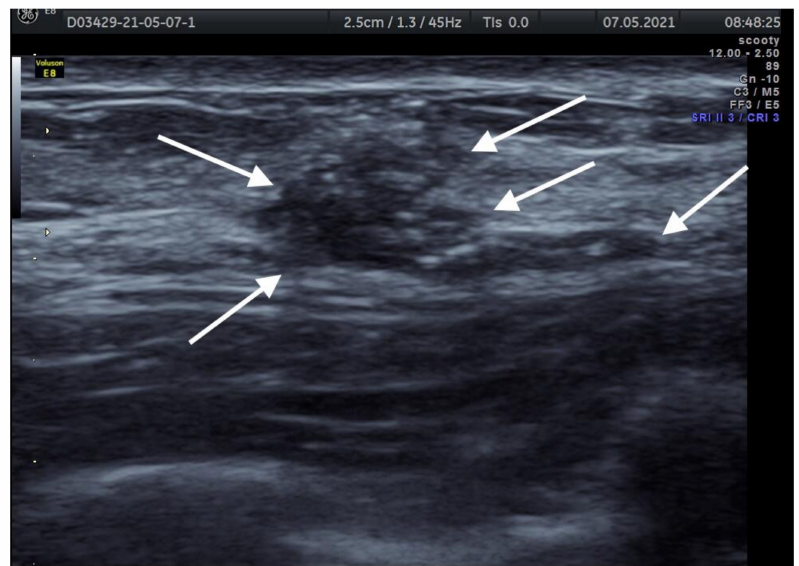
Figure A1. Ultrasound image of a BI-RADS-US class 4c diabetic mastopathy-type lesion measuring 22 × 10 × 11 mm in a 39-year-old female.